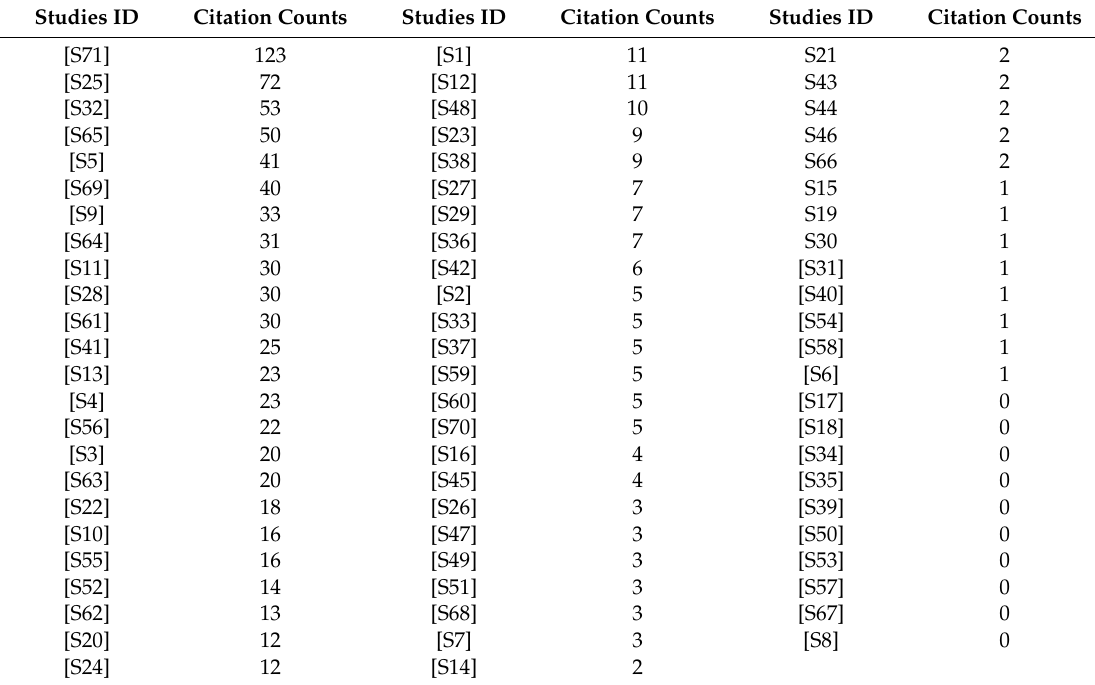
Table 7. An overview of citation counts of the selected